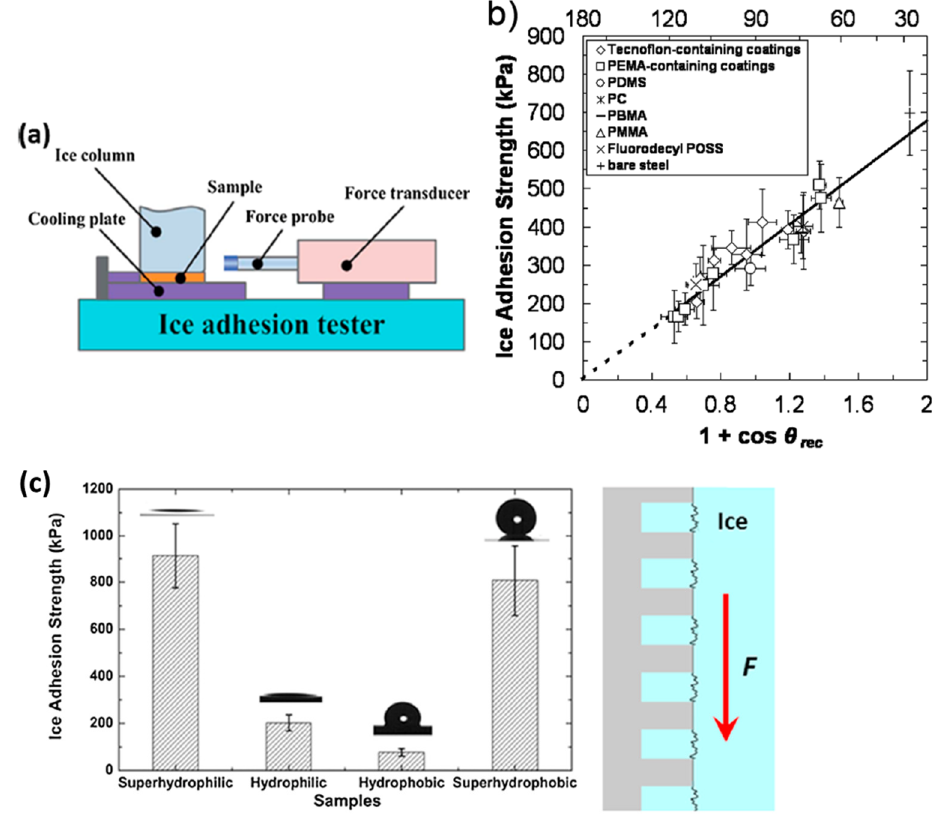
Figure 15. ( a ) Ice adhesion tester under shear mode; ( b ) linear correlation between ice adhesion strength and practical work of adhesion [14]; ( c ) ice adhesion strength in shear on four di ff erent surfaces on silicon wafer (from superhydrophilic to superhydrophobic) with di ff erent size of nanopores, and the proposed interface model for failure under shear loading [87]. PDMS, polydimethylsiloxane; POSS, fluorodecyl polyhedral oligomeric silesquioxane; PEMA, poly(ethyl methacrylate; PC, polycarbonates; PBMA, poly(butyl methacrylate); PMMA, polymethylmethacrylate.